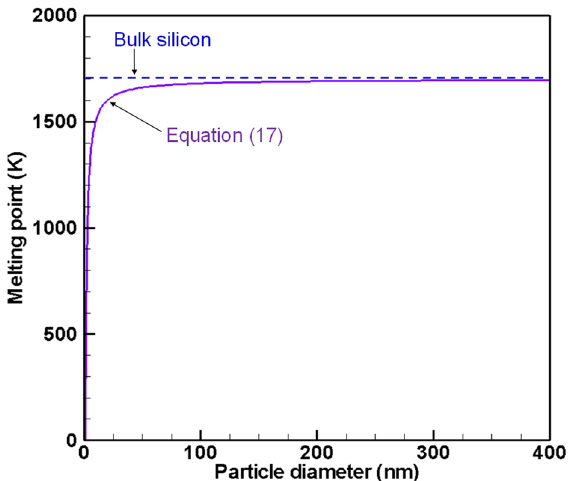
Figure 3. Melting points of bulk silicon and nano-size spherical silicon estimated by Equation